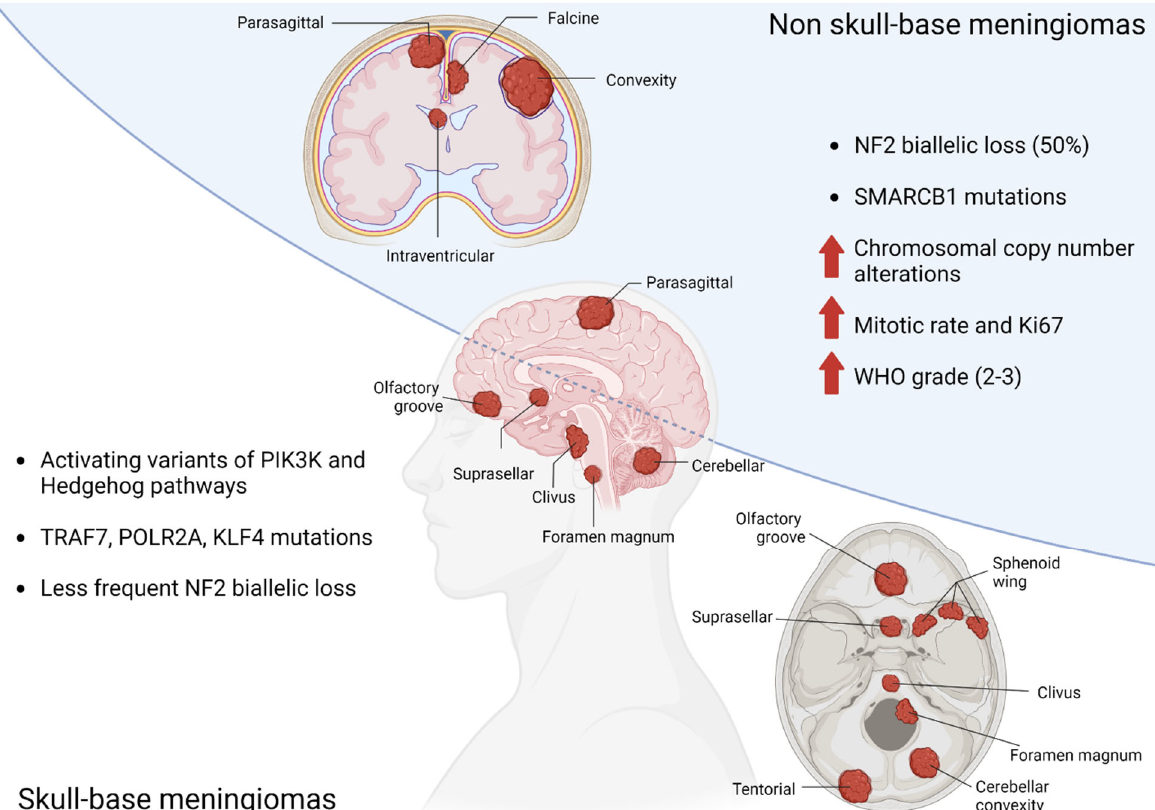
Figure 1. Genetic abnormalities related to anatomic location of meningiomas.